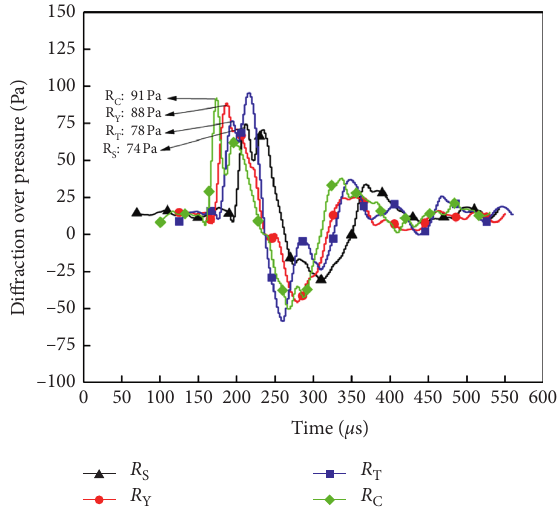
Figure 6: Diffraction overpressure as a function of time for the various corrugation shapes on steel